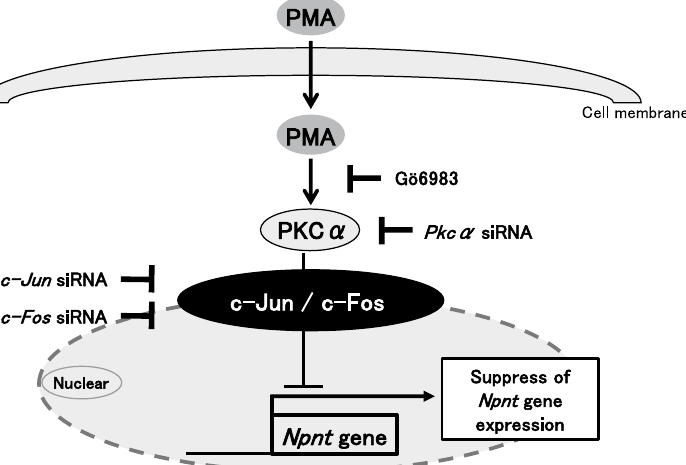
Figure 6. Model of down-regulation of Npnt gene expression by PMA. Activation of PKC signaling by PMA, Npnt gene expression was suppressed via the transcription factors c-Jun and c-Fos. (This image was drawn using Microsoft Office Power Point version